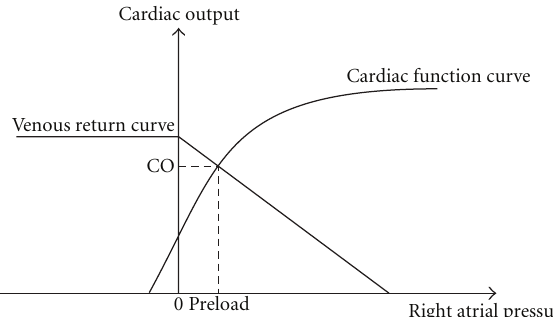
Figure 3: The relationship of venous return and cardiac function in determining cardiac output. As depicted in the venous return curve, venous return reduces with increasing right atrial pressure. The cardiac function curve illustrates the e ff ect of increasing right atrial pressure on cardiac output (CO). Increasing right atrial pressure causes as increase in CO until a plateau (flat portion) is reached. At equilibrium, CO is determined by the point where two curves cross each other. The right atrial pressure at this point is the preload. The cardiac function curve is also known as the Frank-Starling